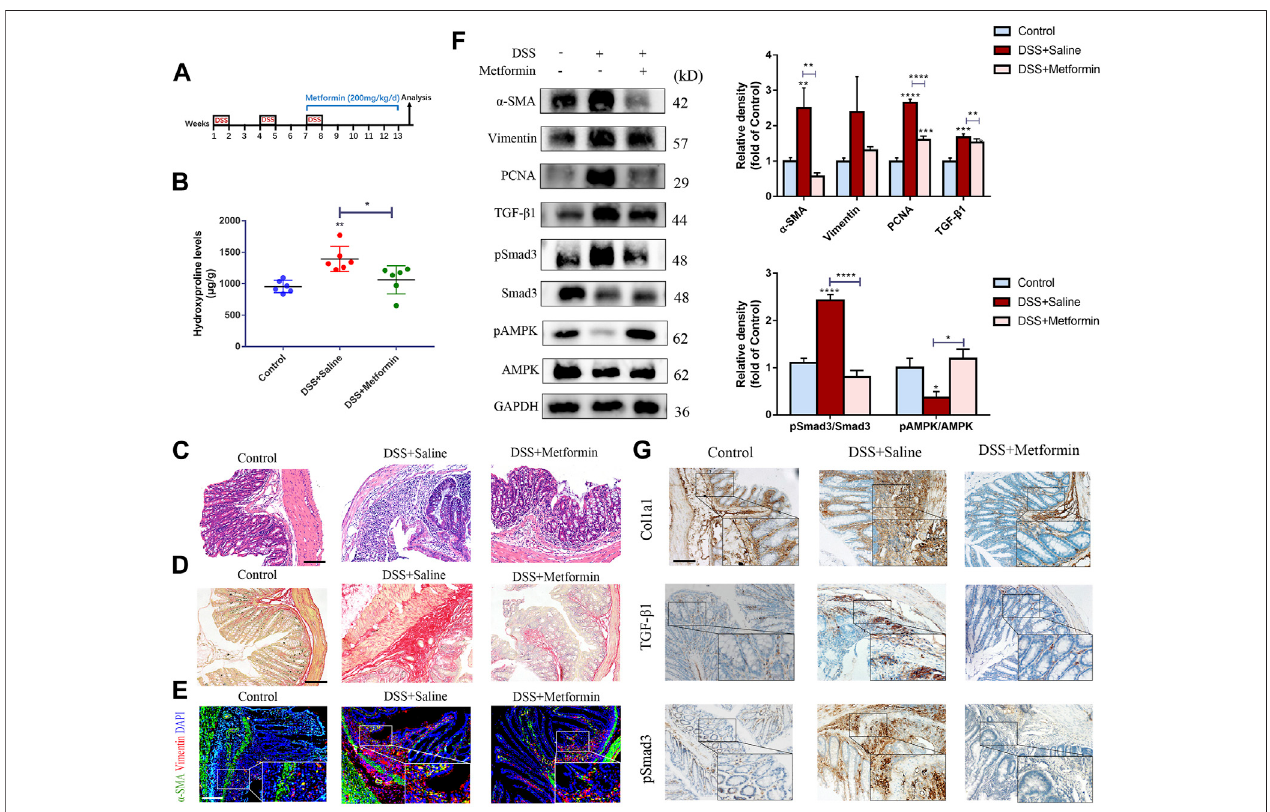
FIGURE4| Therapeuticmetforminapplicationattenuatesintestinal fi brosisinDSSmicemodel. (A) MiceexperimentalprotocolofDSScolitis. (B – D) Colonictissues wereanalyzedby (B) Hydroxyprolineassay, (C) H&Estainingand (D) SiriusRedstaining( n =6/group). (E) Colonictissuesofmicewerestainedwith α -SMAandVimentin (F) α -SMA, Vimentin, TGF- β 1, pSmad3 and Smad3 expressions were evaluated in colonic tissue sections by western blot. And relative density of each protein to the levels ofGAPDH and pSmad3/Smad3 ratios areshown. (G) IHC analysiswas conducted ( n = 6/group). Scalebars, 100 μ m. Quantitative results were analyzed by one-way ANOVA test. * p < 0.05; ** p < 0.005; **** p <